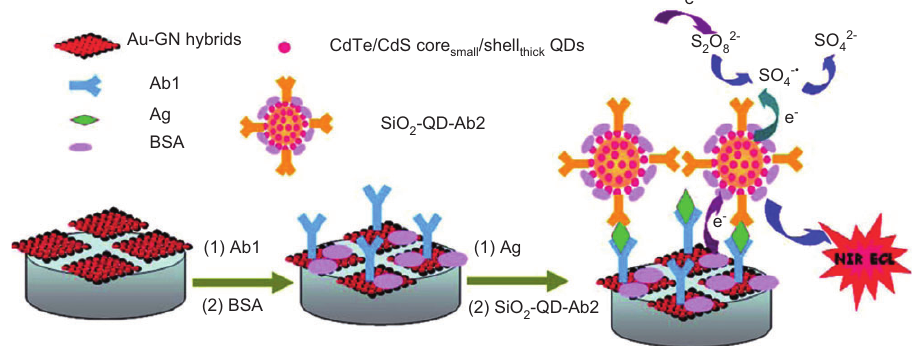
Figure 4 NIR ECL immunoassay of HIgG with dual amplification strategy.